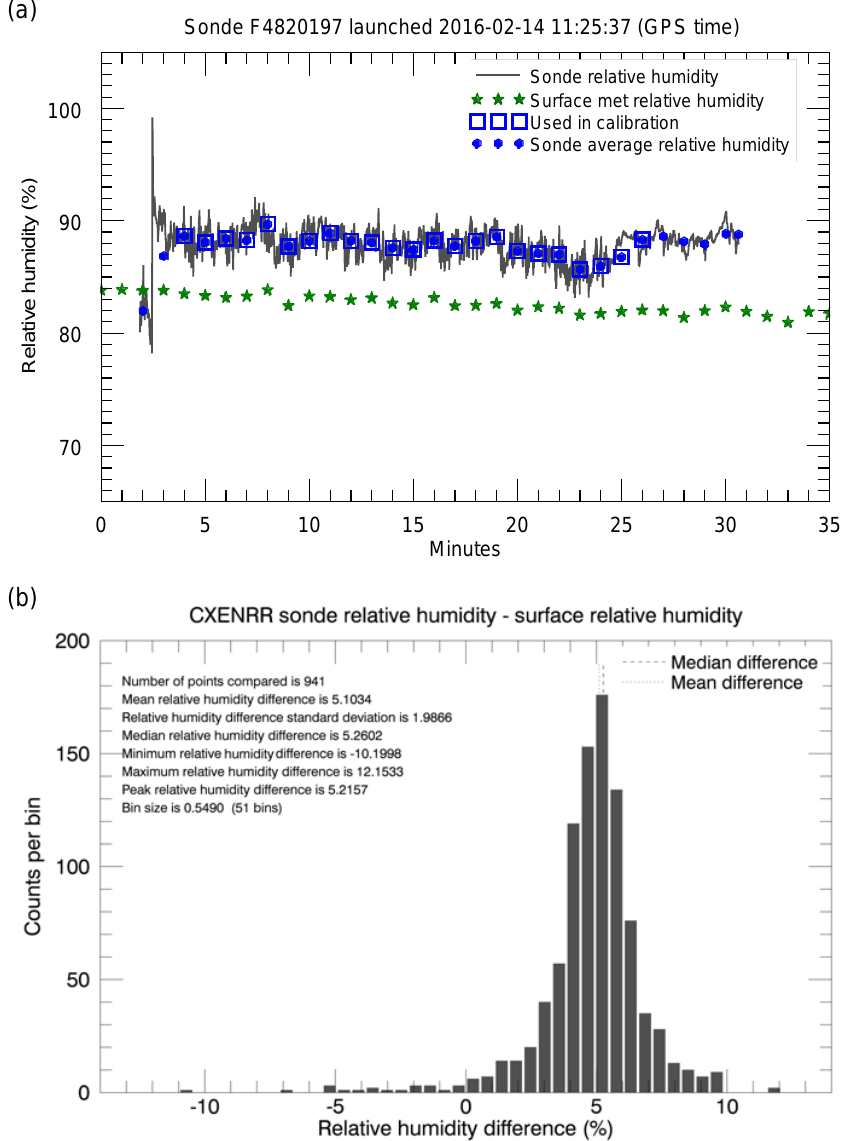
Figure 7. (a) 1s radiosonde relative humidity and 1min average radiosonde relative humidity prior to the 14 February 2016, 12:00UTC launch at Kiritimati, together with 1min values of HMP45C relative humidity. The initial portion of the radiosonde data covers the period when the radiosonde was transported from the Vaisala GC25 ground-check unit inside the bungalow out to the surface station. The averaged values from this radiosonde that were part of the set used to calibrate the surface humidity instrument are indicated. (b) Differences between 1min average radiosonde humidities and 1min values of relative humidities from the HMP45C when the radiosonde was co-located with the Kiritimati surface instruments prior to launch. All available good surface data and the corresponding radiosonde data (101 radiosondes) are